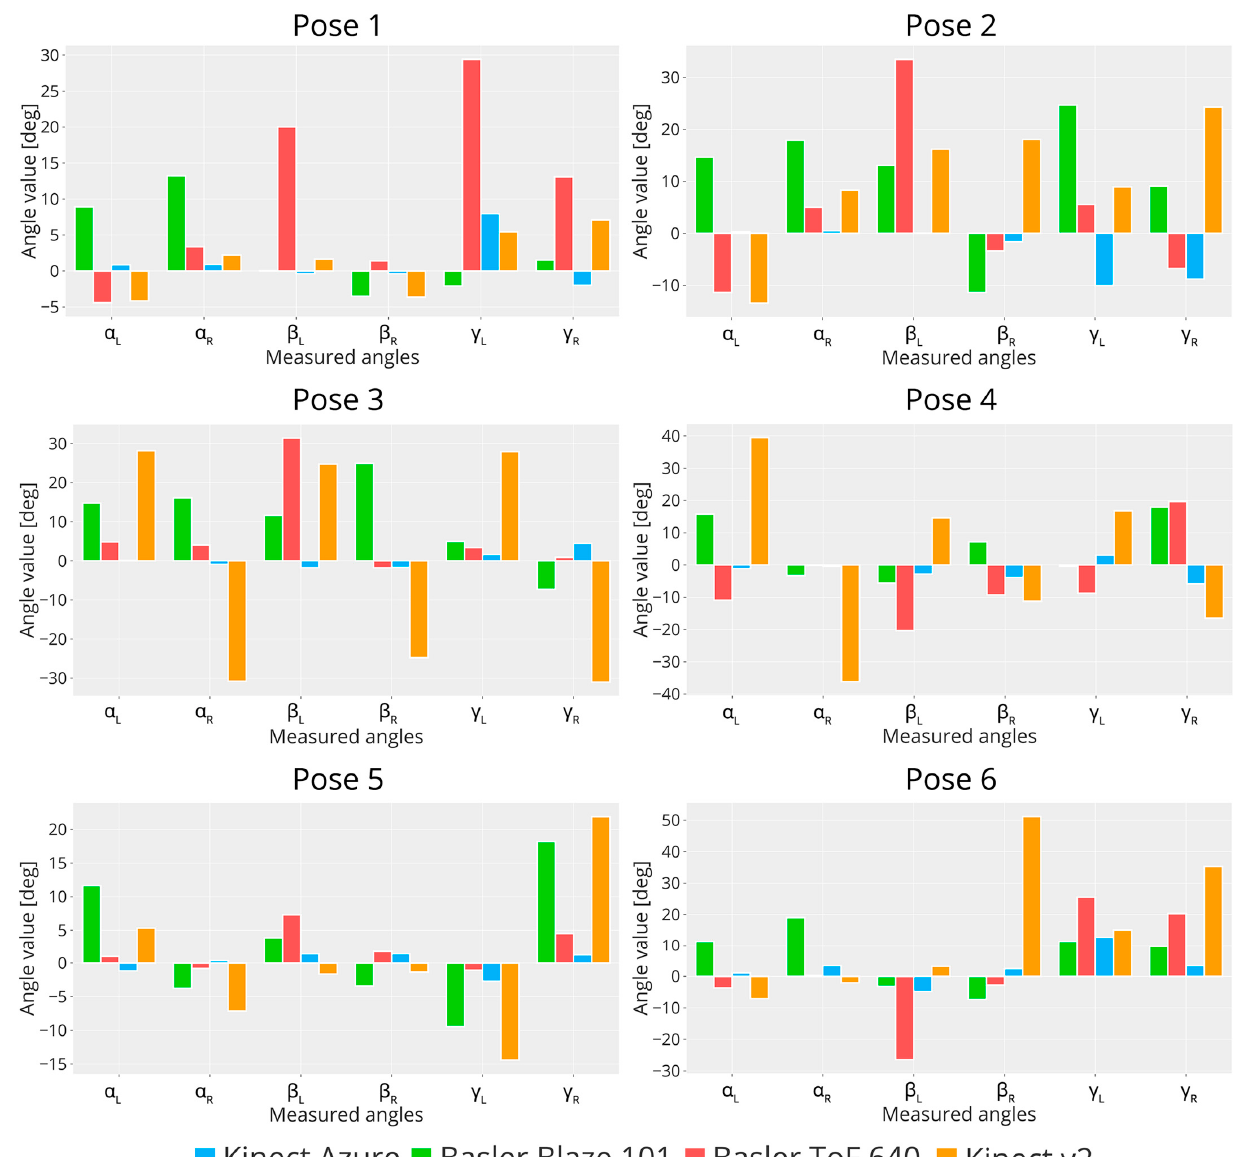
Figure 11. Bar plots representing the measuring error achieved by the three sensors and the old Kinect v2 for the six poses considered. The error is computed by subtracting the angle value ob- tained from Konica Minolta from the camera’s